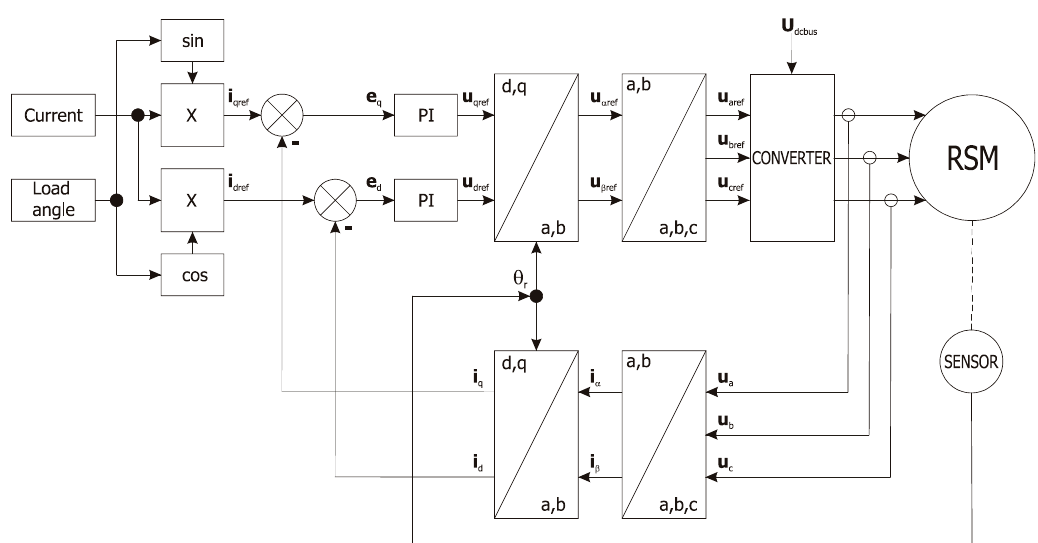
Figure 7. Block diagram of the control in a current loop with a possibility to enter the load angle.